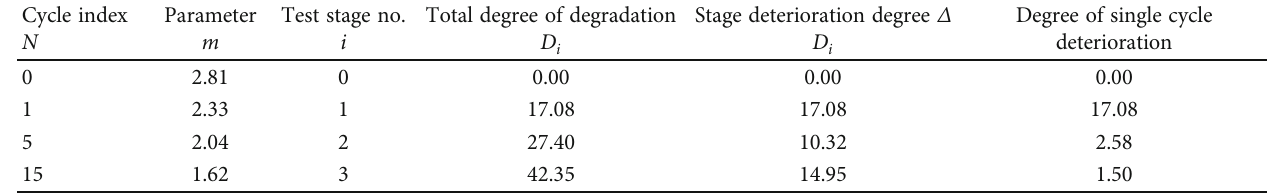
ff ect of water-rock interaction. Table 4: Analysis of the deterioration of the parameter F 0 of sandstone under the e Cycle index Parameter Test stage no. Total degree of degradation Stage deterioration degree F D Δ D N i 0 i i